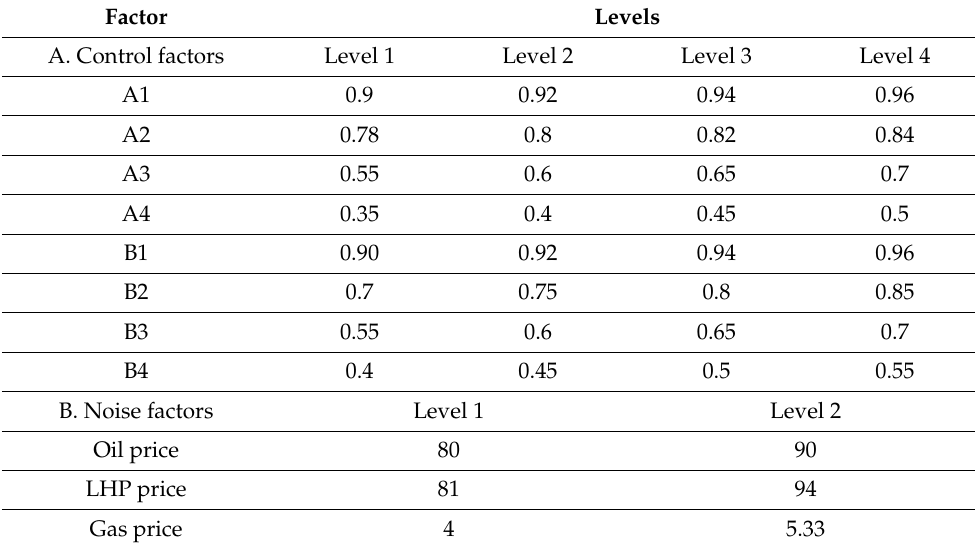
Table 4. Selected control and noise factors of the